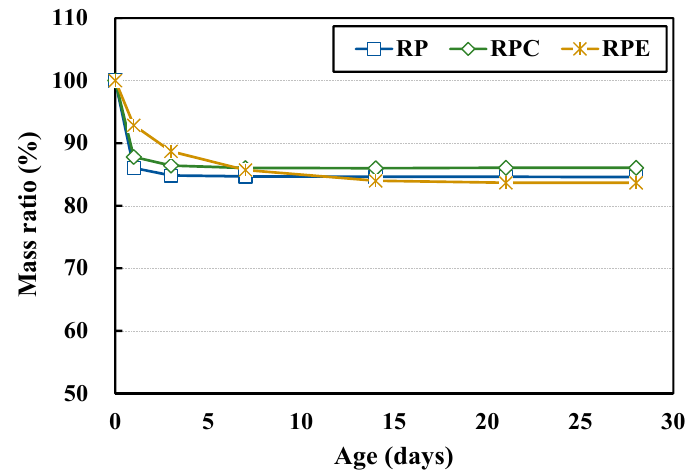
Figure 5. Rates of mass change in the red clay binder specimens.